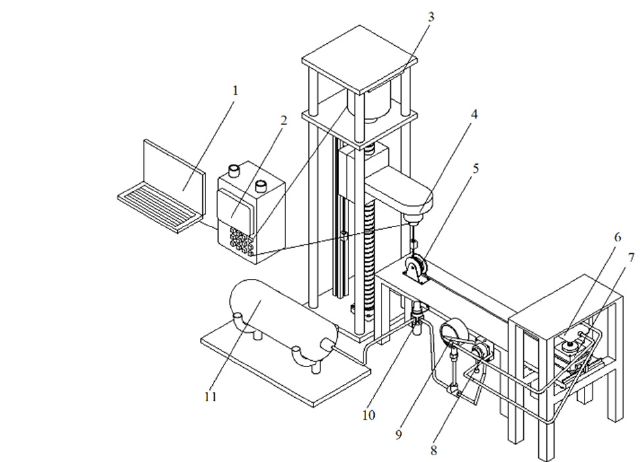
Figure 1. Self-made device for measuring shear characteristics. Note: 1. Computer; 2. Controller; 3. Mechanical test machine; 4. Force sensor; 5. Pulley; 6. Cylinder; 7. Shear box; 8. Gas circuit switch; 9. Pressure gauge; 10. Pressure regulating valve; 11. Air compression machine .